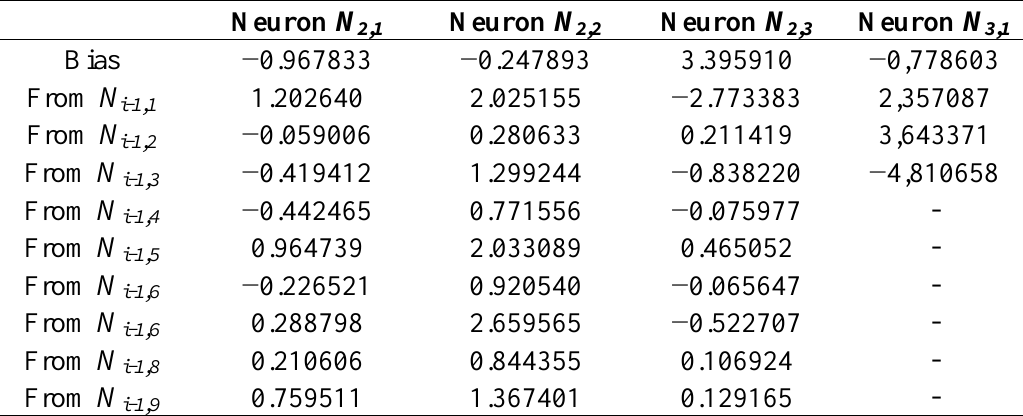
Table 1. Connection weight of the proposed